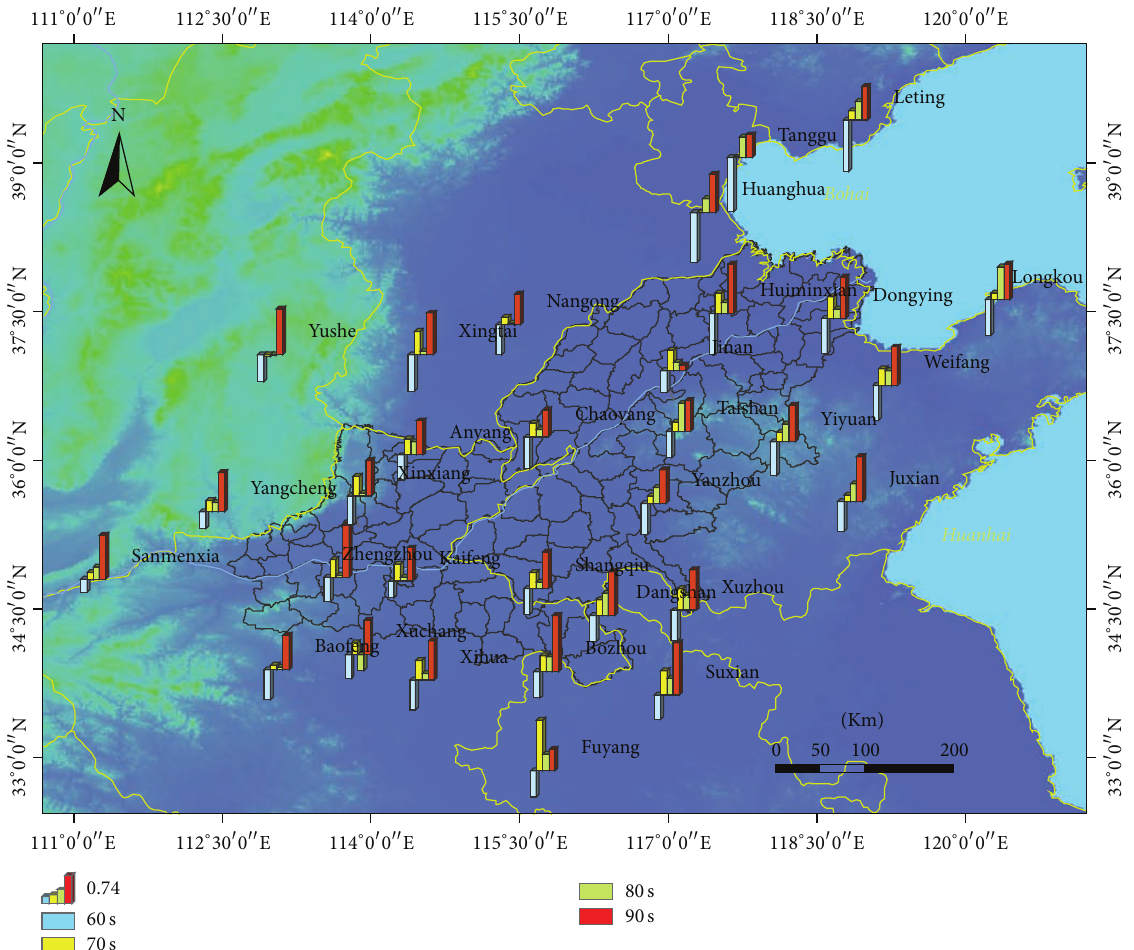
Figure 4: Average temperature change trend rates at each station in the Lower Yellow River Region across different time periods(unit of measurement ∘ C/10